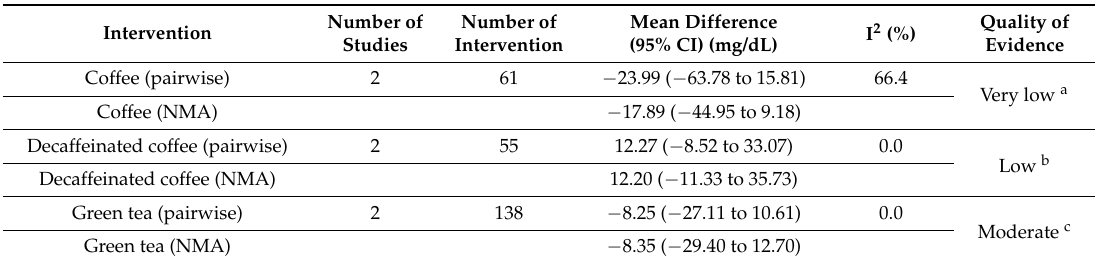
Table 3. Intervention effect on 2-h oral glucose tolerance test results for blood glucose vs. placebo/water. Number of Intervention